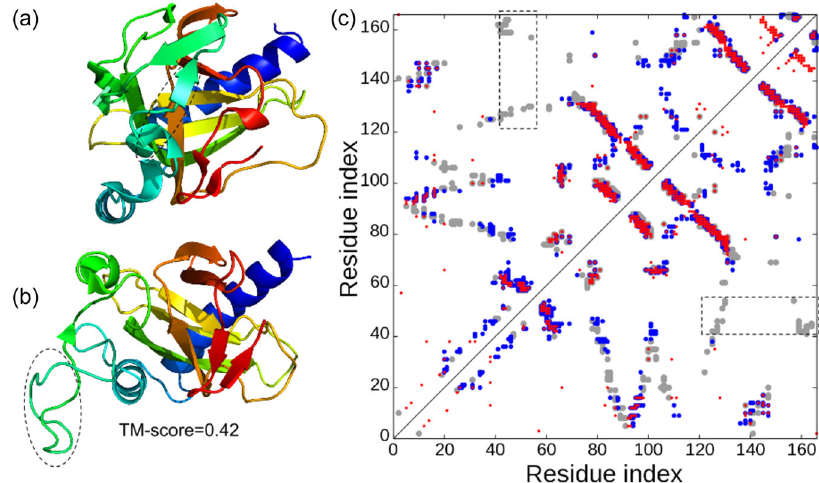
Fig. 5 An example case (PDBID: 2xvsA [https://doi.org/10.2210/pdb2XVS/pdb]) for which C-QUARK failed to generate a correct fold. a The native structure with a dashed circle highlighting the regions (40 – 43 and 51 – 52) which should be a 3 10 -helix and beta -strand, respectively. However, the secondary structure predictor, PSSpred, predicted these regions as coils. b The best in the top fi ve models from C-QUARK with the dashed circle marking the coil region that was not folded correctly due to the wrong SSE prediction. c The contact-maps for the native structure (gray circles), C-QUARK model (blue) and sequence-based predictions (red), where the rectangles highlight the above-mentioned region which has no predicted